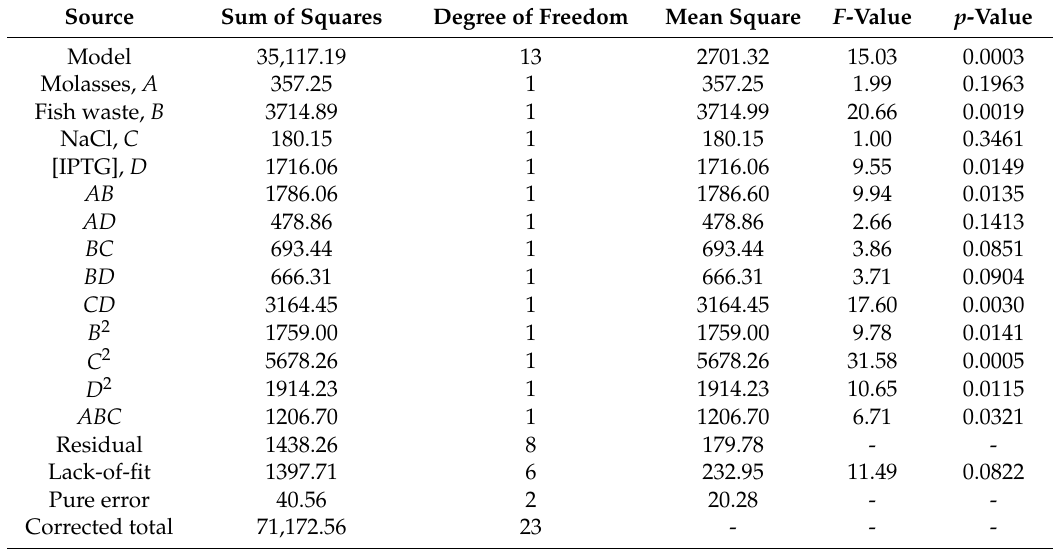
Table 5. ANOVA for the Quadratic Model Developed for the Production of T1